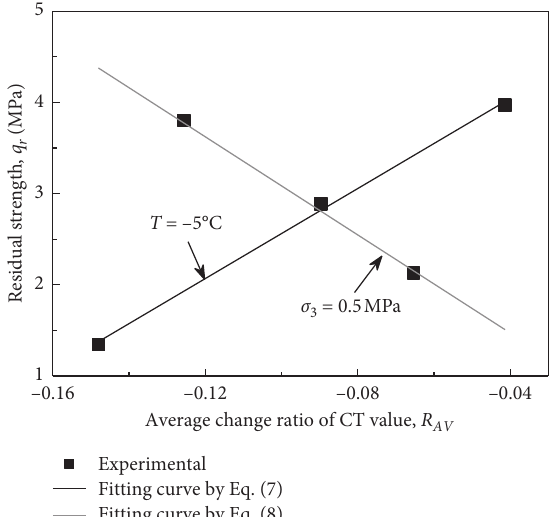
Figure 11: Relationship between residual strength and the average change ratio of CT